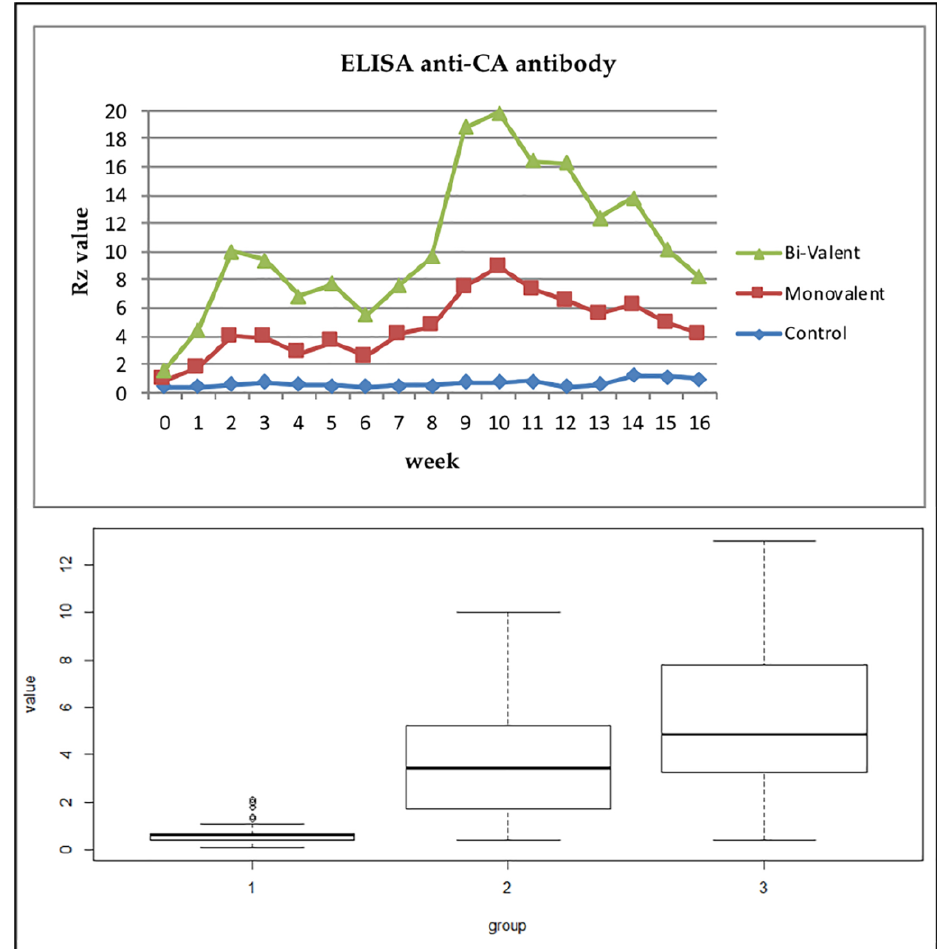
Figure 1. Results of the estimation of the anti-CA antibodies in the serum using ELISA (graphs and boxplots). Rz value: Proportional to the amount of Ab according to the ELISA manual; group 1 (control), group 2 (mono-valent vaccine), group 3 (bi-valent vaccine).